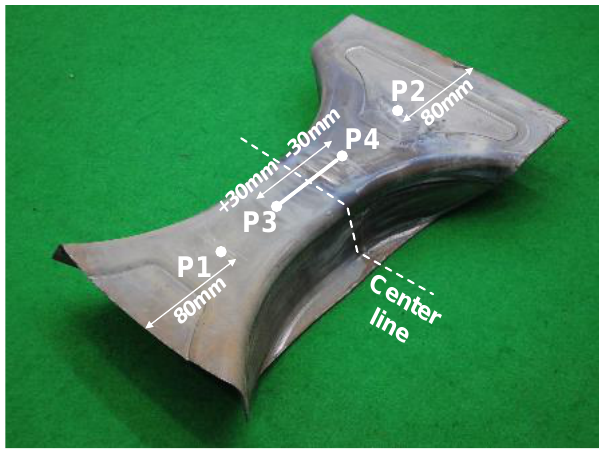
Figure 11. Measurement points for verification of the suggested prediction model.